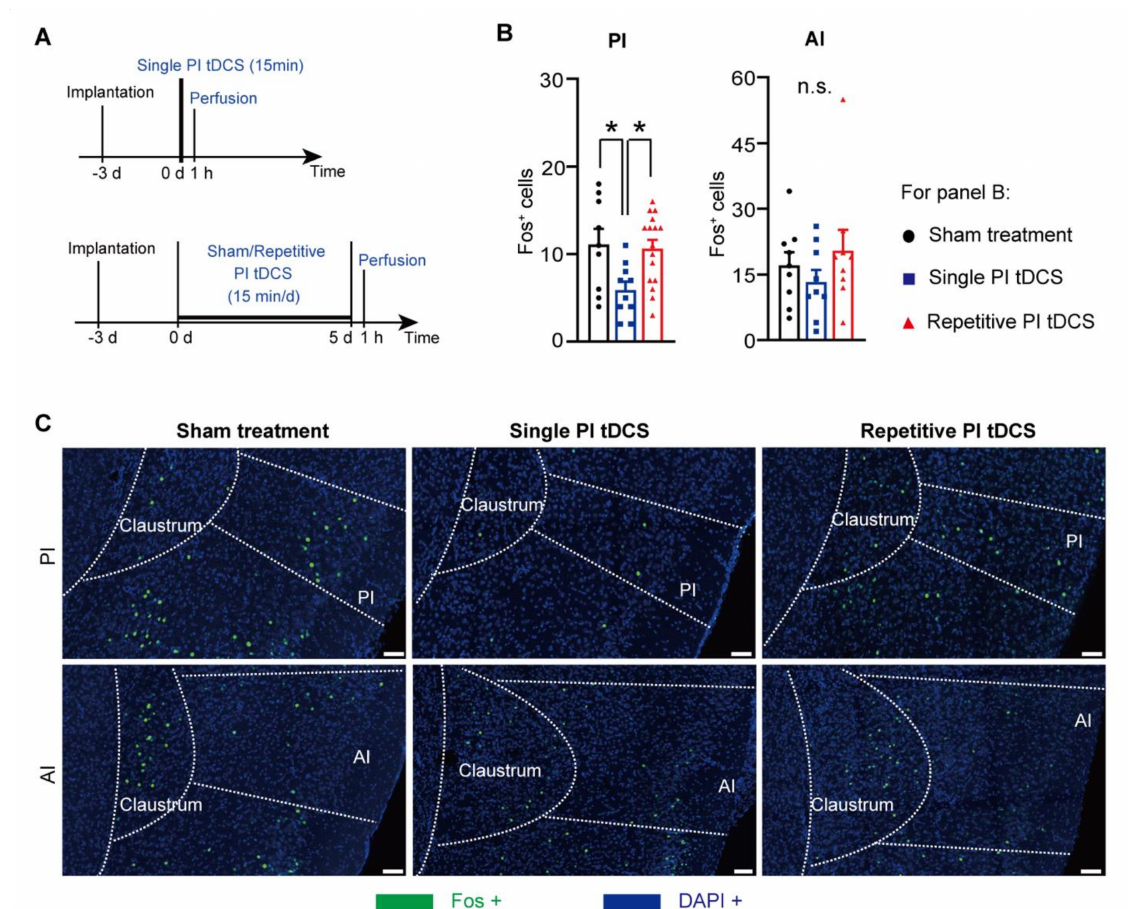
Figure 5. Immunohistochemical analysis of Fos, the product of the activity marker gene c-Fos in the anterior insula (AI) and PI following stimulation of PI. ( A ) Experimental scheme for testing the impact of a single PI tDCS session or repetitive stimulation over five consecutive days compared to sham treatment. ( B ) Quantitative analysis of number of Fos-expressing cells per region of interest in the PI and AI. ( C ) Typical examples of Fos immunoreactivity with DAPI counterstaining over the PI and AI; scale bars represent 100 µ m; n = 9 sections from three mice in the sham treatment group, n = 10 sections from four mice in the single PI tDCS group and n = 16 sections from four mice in the repetitive PI tDCS group; repeated ANOVA with Sidak’s multiple comparisons tests were performed; * p < 0.05 as compared to the corresponding control group. n.s.: non-significant. Data are represented as mean ±